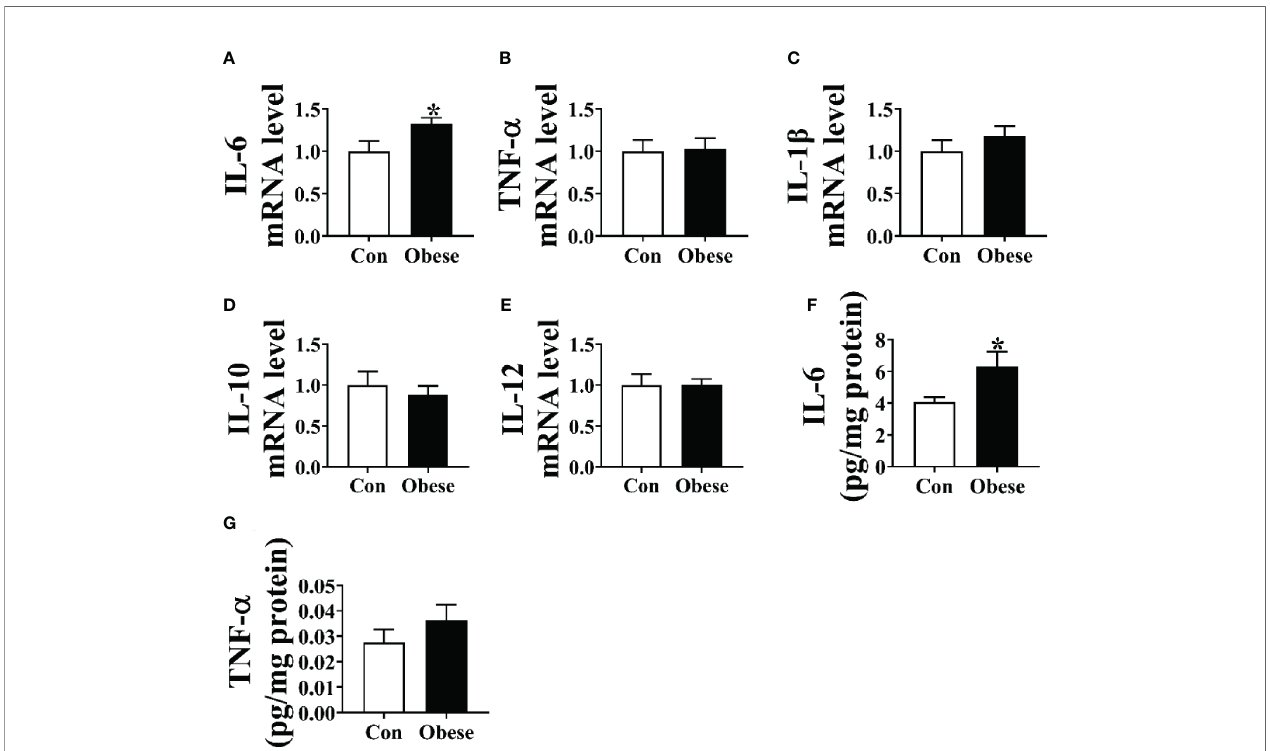
FIGURE 3 | Placental in fl ammatory cytokine levels. (A – E) The mRNA levels of IL- 6, TNF- a , IL -1 b , IL -10, and IL -12 in placentae. The concentrations of IL-6 (F) and TNF- a (G) in placenta. Values are mean ± SEM, n = 8. “ * ” indicates statistically signi fi cant differences ( P <